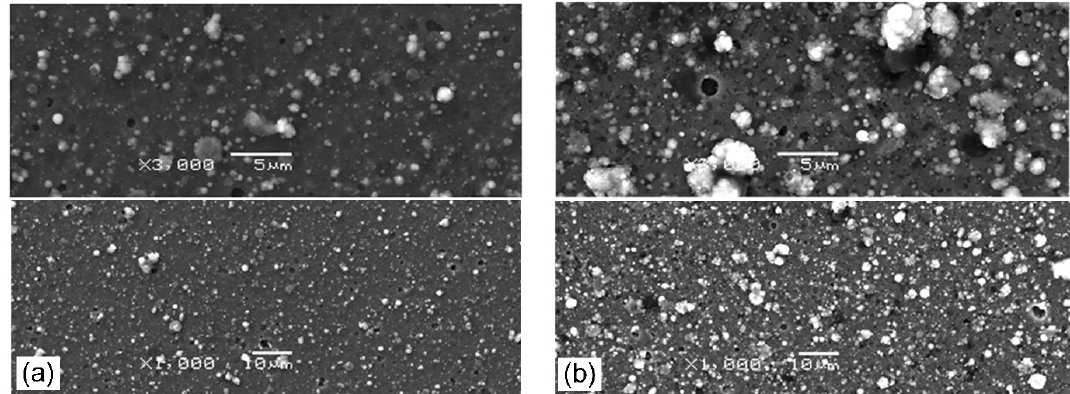
Figure 5. Morphology of of AlCrN coatings synthesized at: ( a ) p N2 = 0.8 Pa and ( b ) p N2 = 5 Pa. Each picture shows the area recorded at magnification: 1000 × ( bottom ) and 3000 × ( top ).